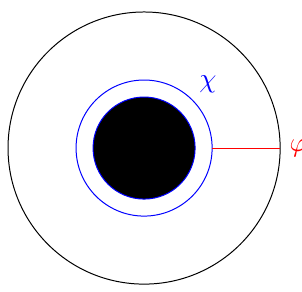
Figure 3 . One point function induced by the cubic coupling χ 2 ϕ in the BTZ background